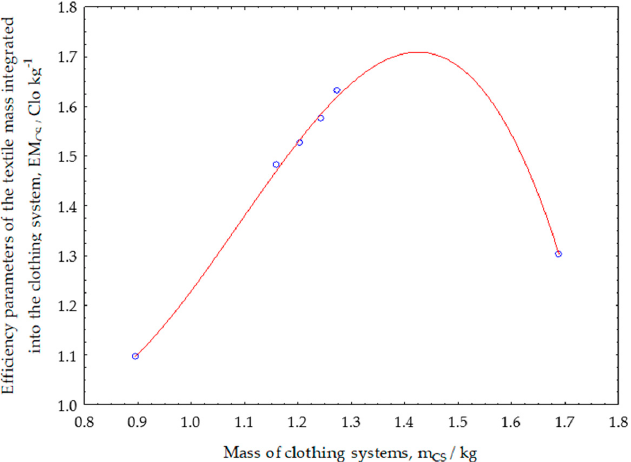
Figure 8. Functional dependence on changes in the values of the efficiency parameters of the textile mass integrated into the clothing systems.